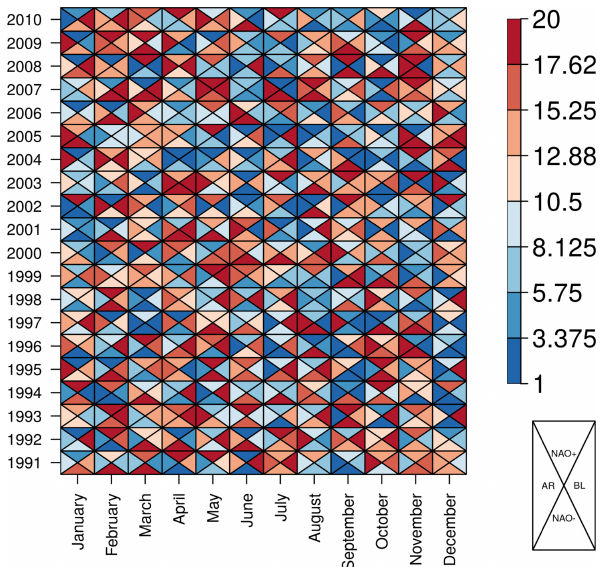
Figure 6. Example of the PlotTriangles4Categories using four dif- ferent